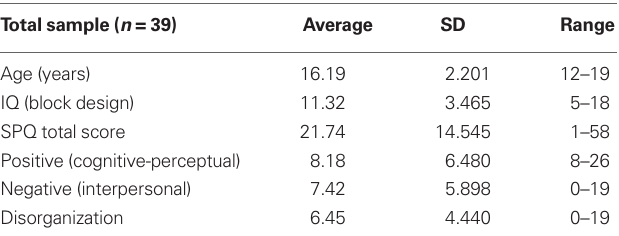
Table 1 | Descriptive and clinical measures of age, intelligence and results of the self-response questionnaires (total and subscale